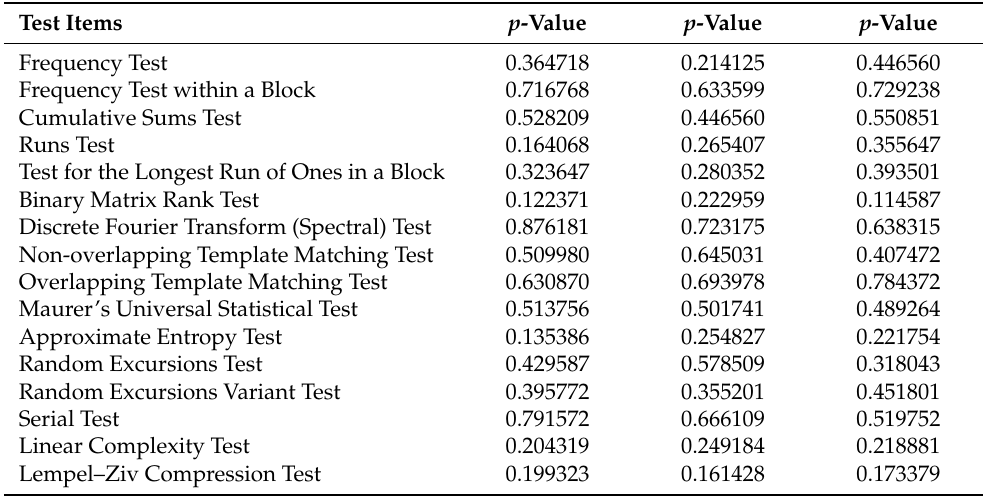
Table 1. The results of the NITST test, where we used three sequences with 125 MB from the data stream generated by the 128-bit nonlinear PRNG and ran all NIST test items.